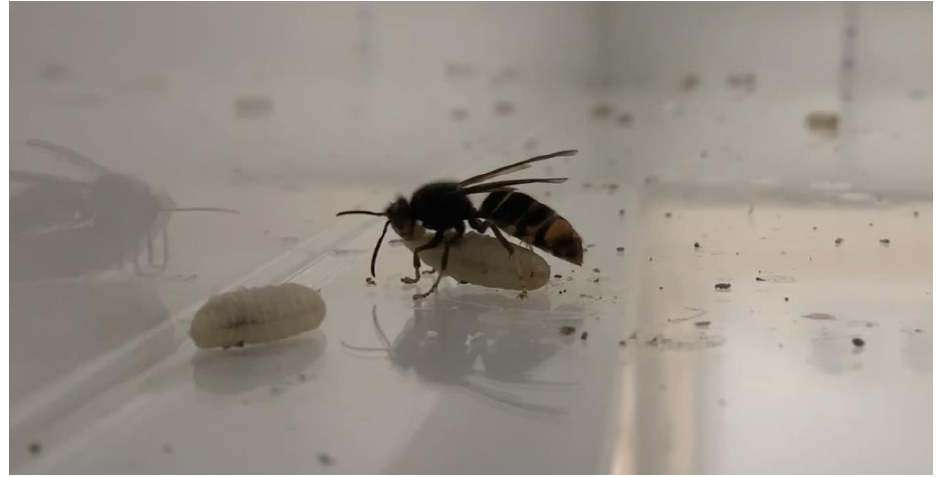
Figure 4. Adult Vespa velutina hornet removing a larva from the nest, with another previously re- moved larva.